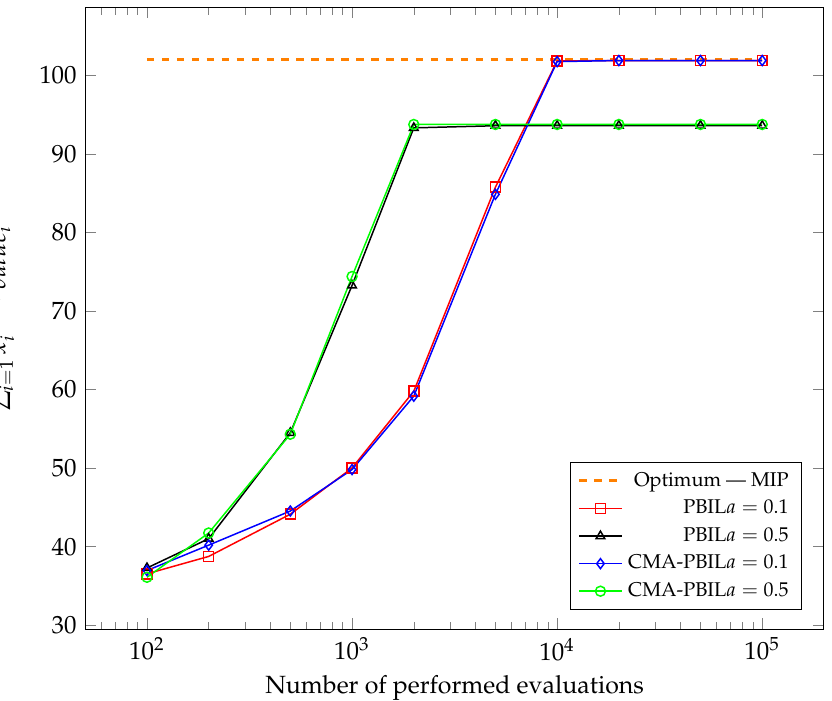
Figure 1. The average of the maximal values of the objective function calculated so far, test case no